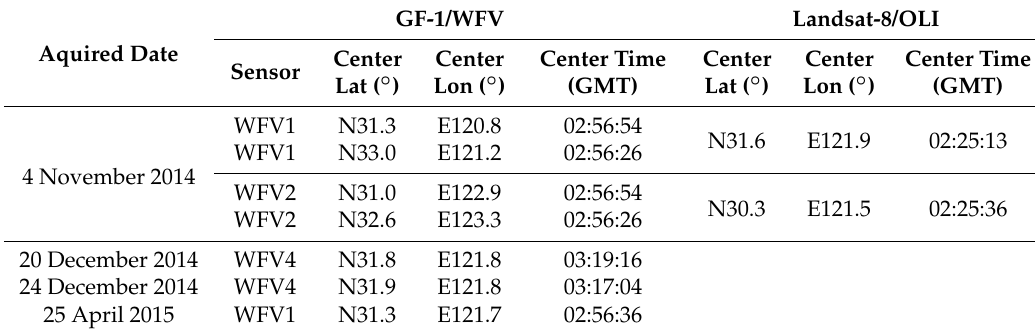
Table 2. The sensor ID (of GF-1/WFV), scene center latitude/longitude (in degree) and scene center time (Greenwich Mean Time) of images used in this